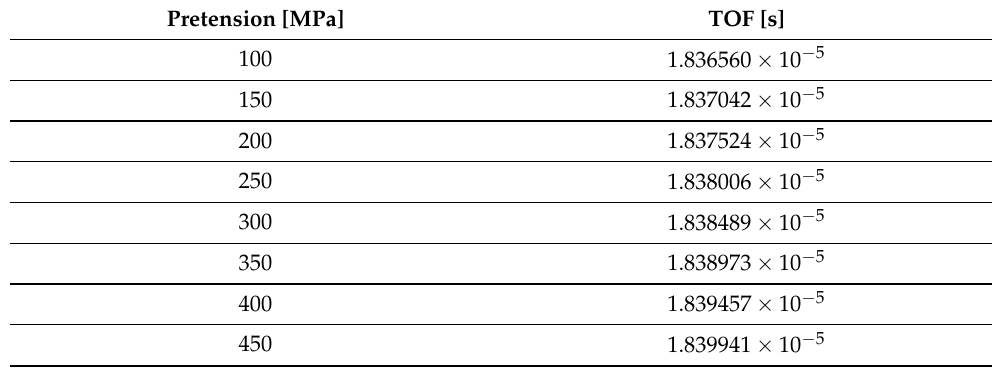
Table 2. Computed TOF for the different bolt pre-tensioning